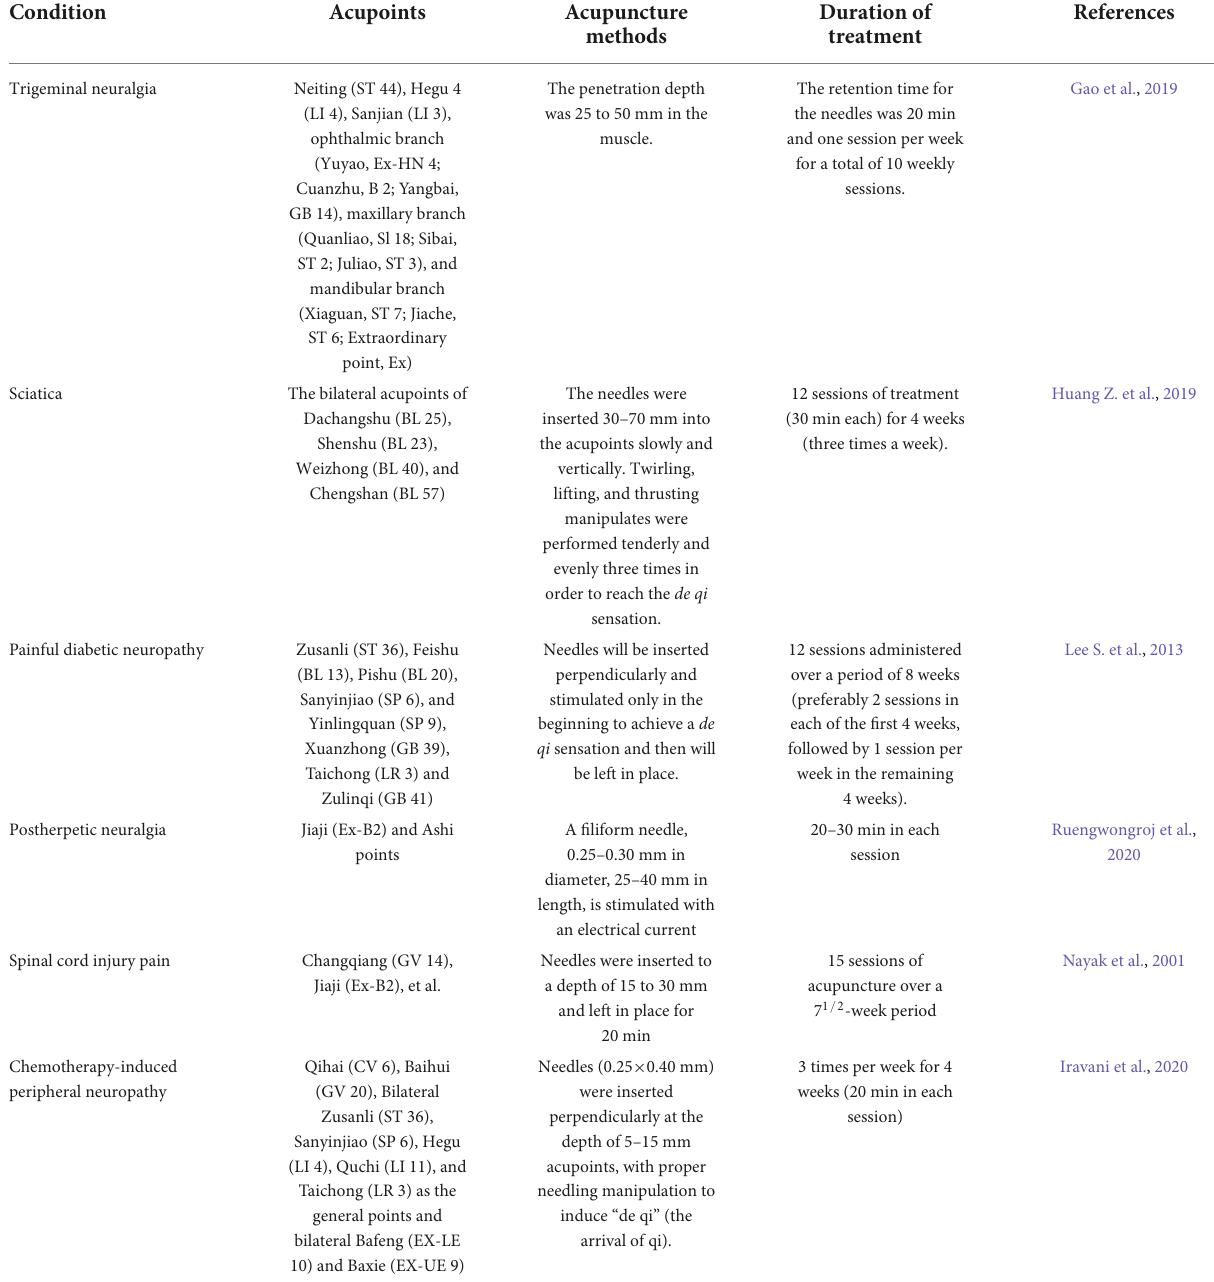
TABLE 1 Acupuncture methods for neuropathic pain caused by different